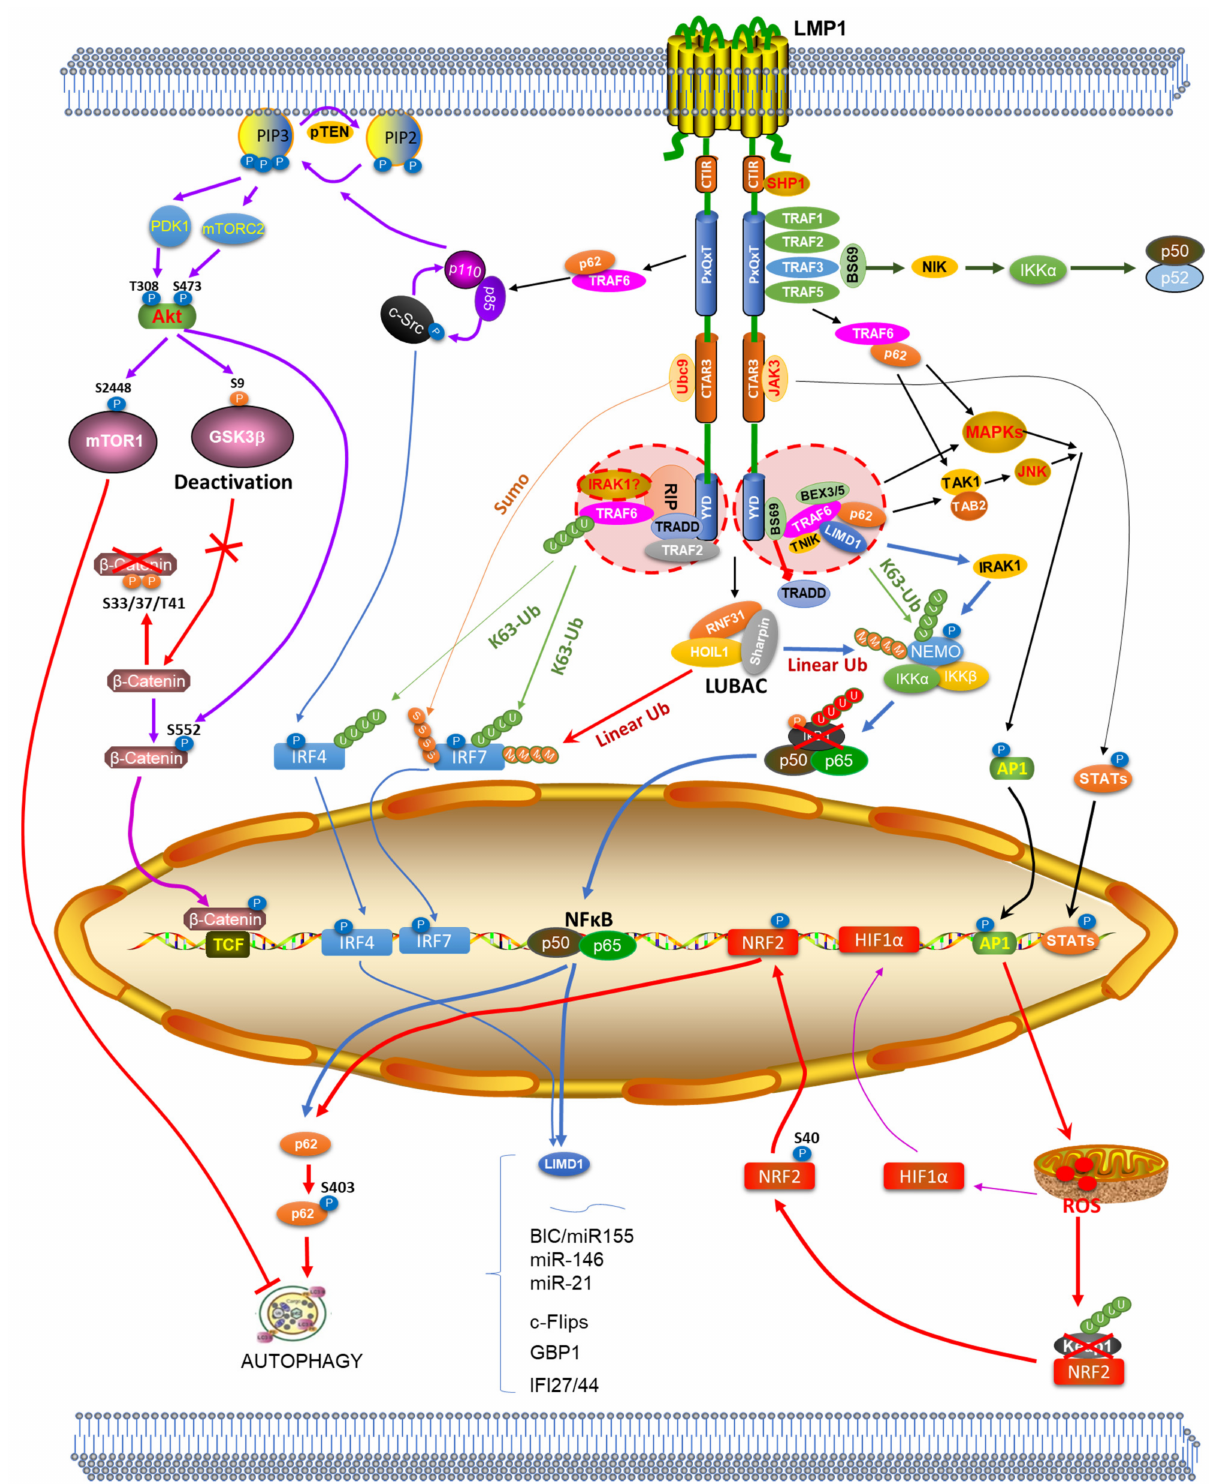
Figure 3. An updated LMP1 signaling pathway. The involvement of LUBAC, LIMD1 and p62 in the LMP1 signal transduction is shown. LIMD1 expression is induced by NF κ B and IRF4, and p62 expression is induced by NF κ B and NRF2. The induction of p62-mediated selective autophagy and the activation of NRF2-mediated antioxidative defense by LMP1 signaling are